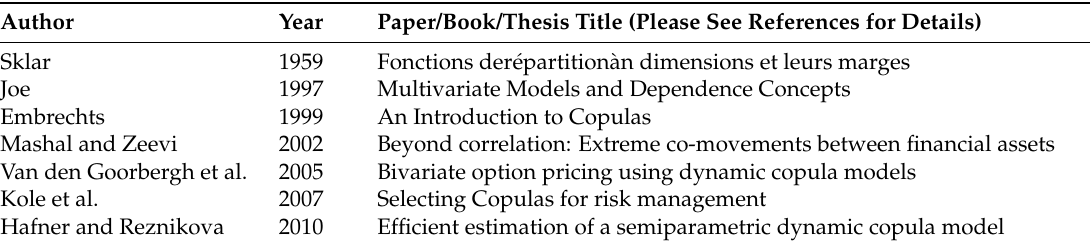
Table 1. Selected work on